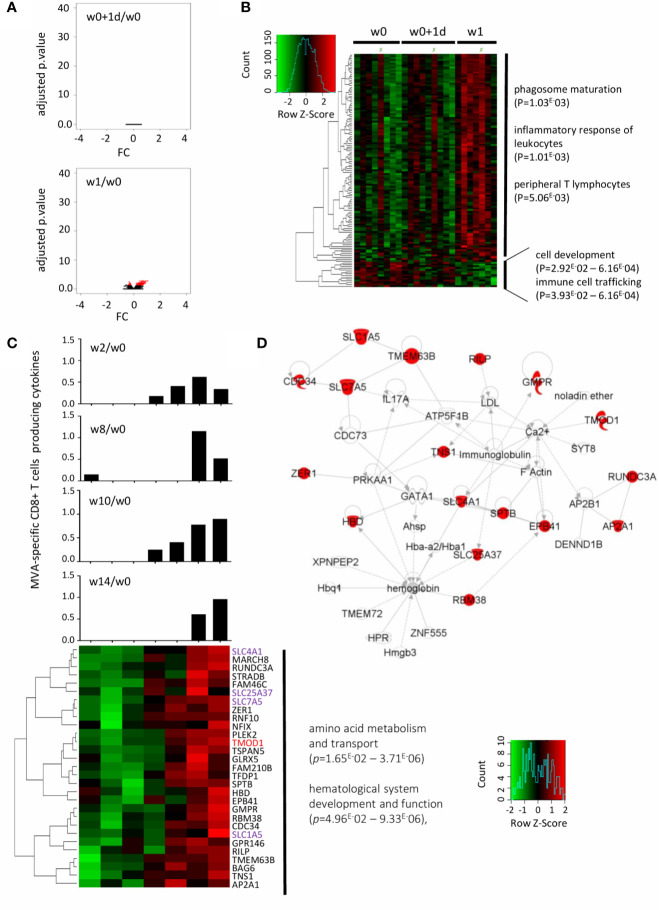
Early gene signature underlying MVA-specific CD8 T-cell responses after t.c. immunization. (A) The volcano plot shows no disruption of gene expression at w0+1d (upper panel) and 129 genes significantly differentially expressed at w1 (lower panel) in the t.c. study arm after MVA-B vaccination compared with baseline (w0), according to the -log10(adjusted p.value) and log2FC. Significance is defined by an adjusted p-value < 0.05 (red). (B) The hierarchical clustering is based on the expression profiles of the 129 genes at 3 time points: w0 (n = 8), w0+1d (n = 9), and w1 (n = 7). The color-gradient scale from green (-2, low) to red (2, high) indicates gene expression levels (log2). The functional enrichment was performed with Ingenuity Pathway Analysis software. p-values by IPA are indicated for each pathway. (C) 29 genes are correlated with the MVA-specific CD8+ T-cell response at w10 determined by the Spearman test with significance based on a p-value < 0.05. The hierarchical clustering is performed on the fold-change expression profile (w1/w0) of these 29 genes (lower panel). The genes in common with the literature (24, 25) are in red, and the family of genes in common with it in purple. MVA-specific CD8+ T-cell response intensity at w2, w8, w10, and w14 for each individual are shown (boolean IFNγ, MIP-1β, IL-2, and/or TNFα). (D) IPA highest scoring biological network from this minimal gene signature. The highlighted genes (red) are positively correlated with MVA-specific CD8+ T-cell responses.